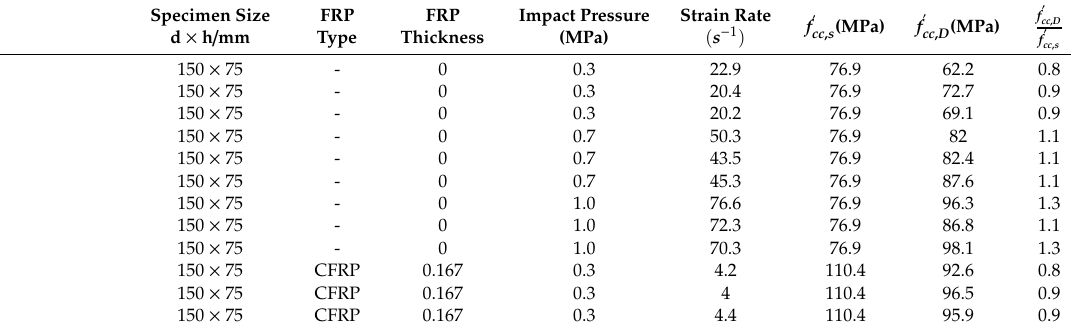
Table 5. Experimental database of FRP-confined high-strength concrete specimens under dynamic compression